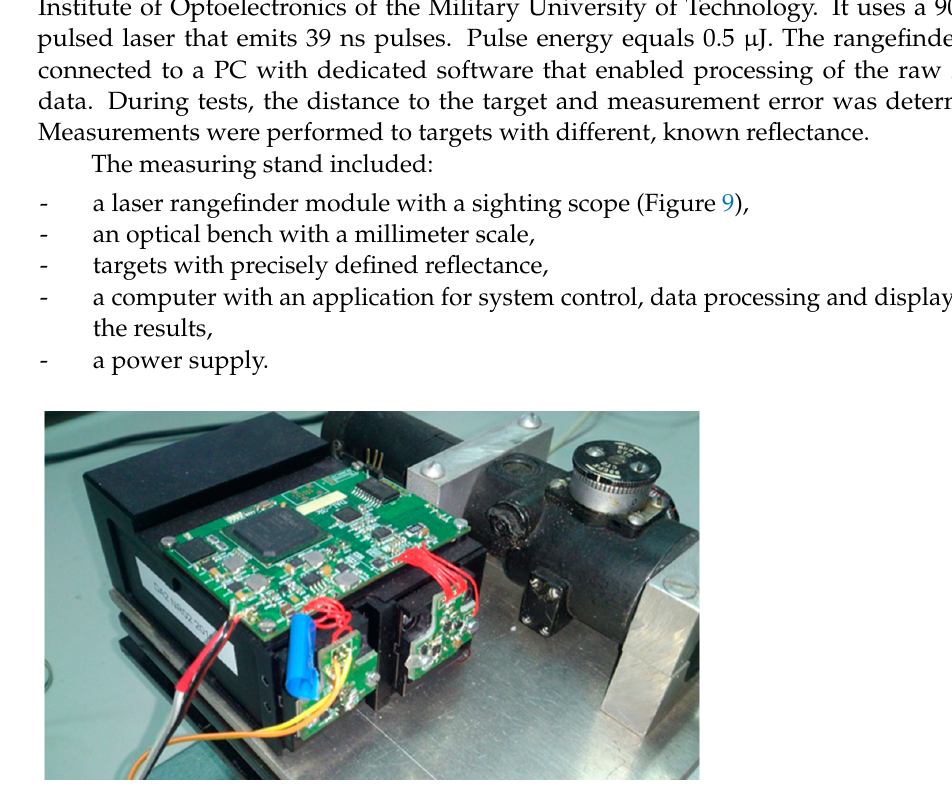
Figure 9. The laser rangefinder module used during experiments.